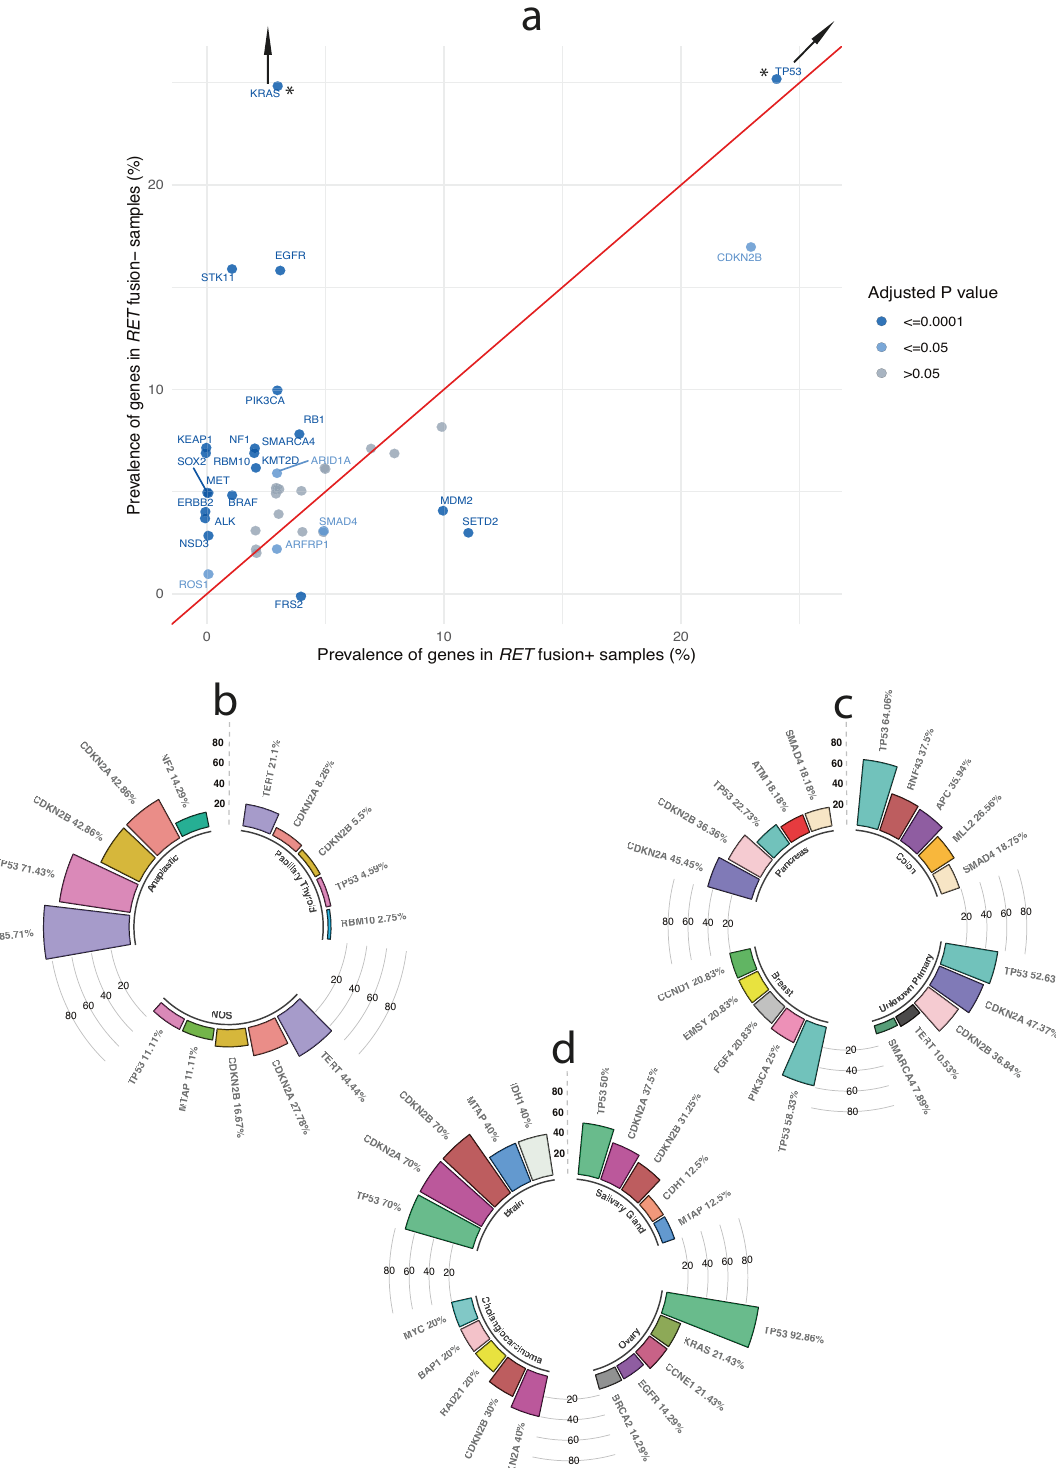
Fig. 3 Prevalence of genes with genomic alterations differed amongst the RET fusion de fi ned cohorts. a RET fusion driven NSCLC has a different genomic pro fi le from RET wild-type NSCLC. Plot indicating prevalence of concurrent genomic variants among advanced RET fusion- positive NSCLC and RET fusion-negative NSCLC. Signi fi cant differences in the prevalence of genes with genomic alterations between RET fusion-positive NSCLC and RET fusion-negative NSCLC are indicated by a light blue ( p ≤ 0.05) or dark blue dot ( p ≤ 0.0001). *Off scale. Prevalence of most common 5 genes with genomic alterations among advanced RET fusion-positive, b thyroid cancer, c colon carcinoma, pancreatic carcinoma, breast carcinoma, unknown primary carcinoma, and d brain tumor, salivary gland carcinoma, ovarian carcinoma and